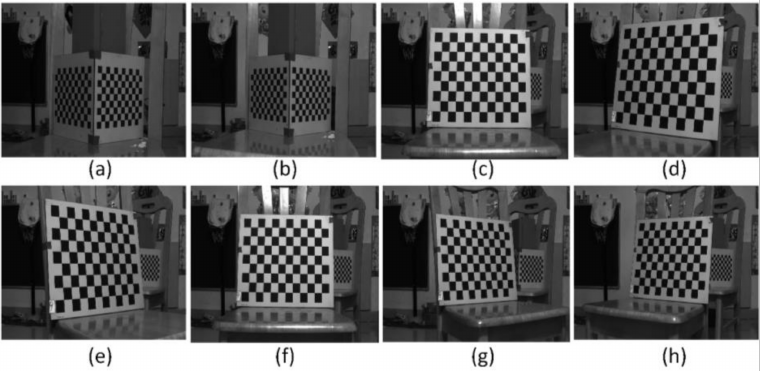
Figure 13. Images for 3D construction when the anamorphic lens was in the vertical position. ( a , b ) refer to images of 3D targets and ( c – h ) refer to the images of a 2D